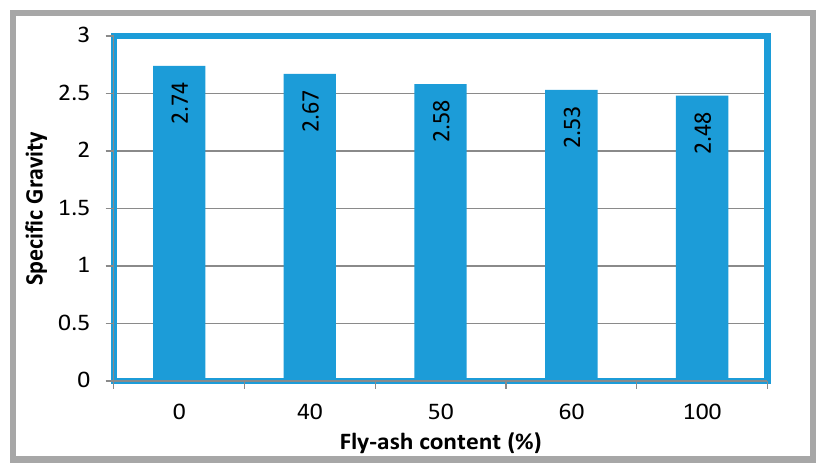
Figure 4. Variations of specific gravity with fly ash content.